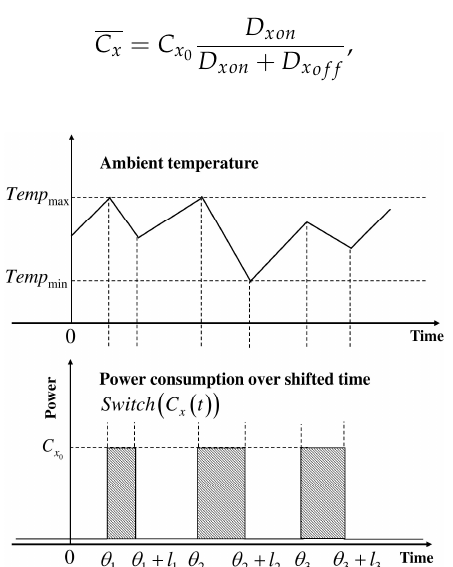
Figure 3. Shifting behavior of the periodic load shift model.